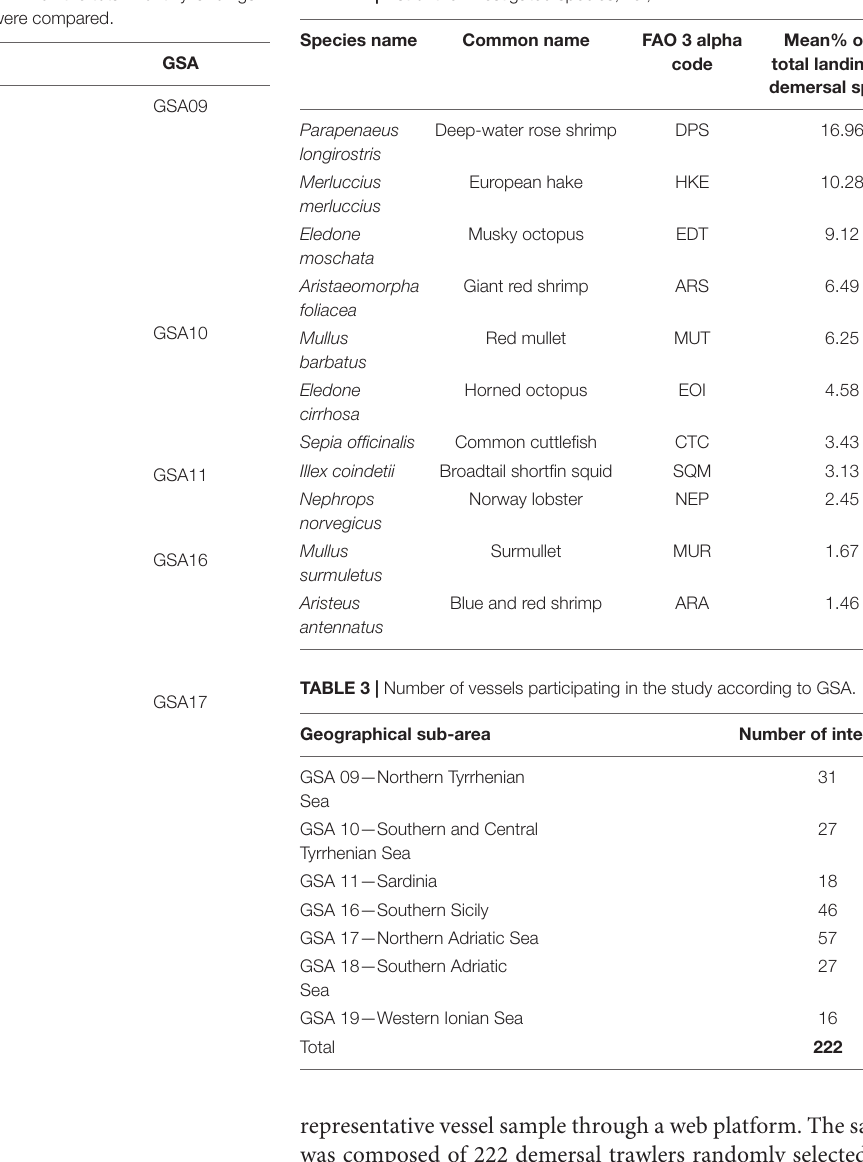
TABLE 2 | List of the investigated species, i.e., N = 11.